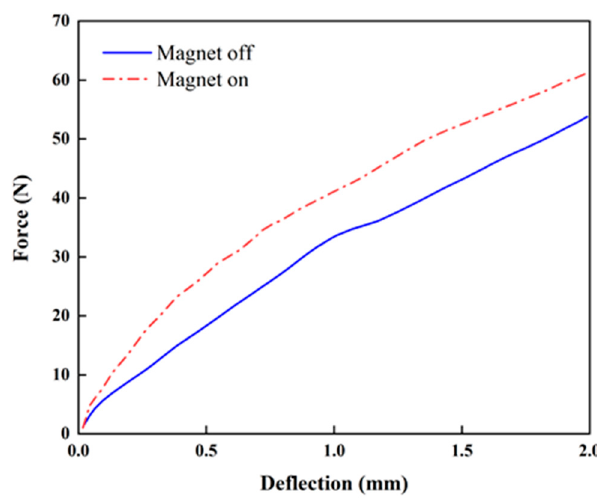
Figure 7. Stiffness variation of specimen 1 (top–bottom PM configuration, Figure 6b).